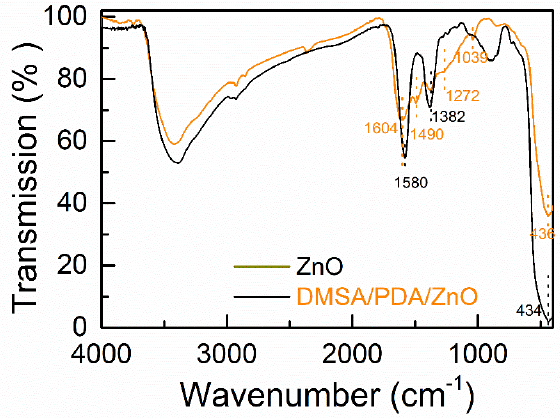
Figure 4. Fourier transform infrared (FTIR) spectra of ZnO and DMSA/PDA/ZnO.